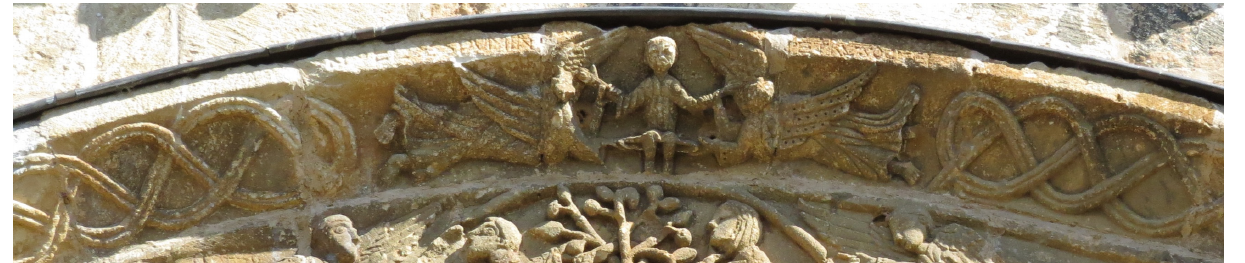
Figure 4. Braided patterns and apotheosis, detail of archivolt, west façade , Saint-Martin Church , 12th c., Besse, Nouvelle-Aquitaine, France. ©Author.